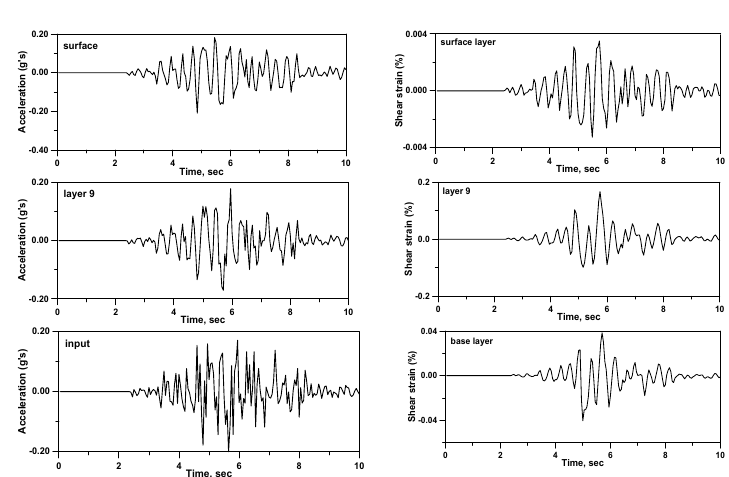
Figure 13 Fig. 13. Acceleration (left column) and strain (right column) time histories at different ground level.